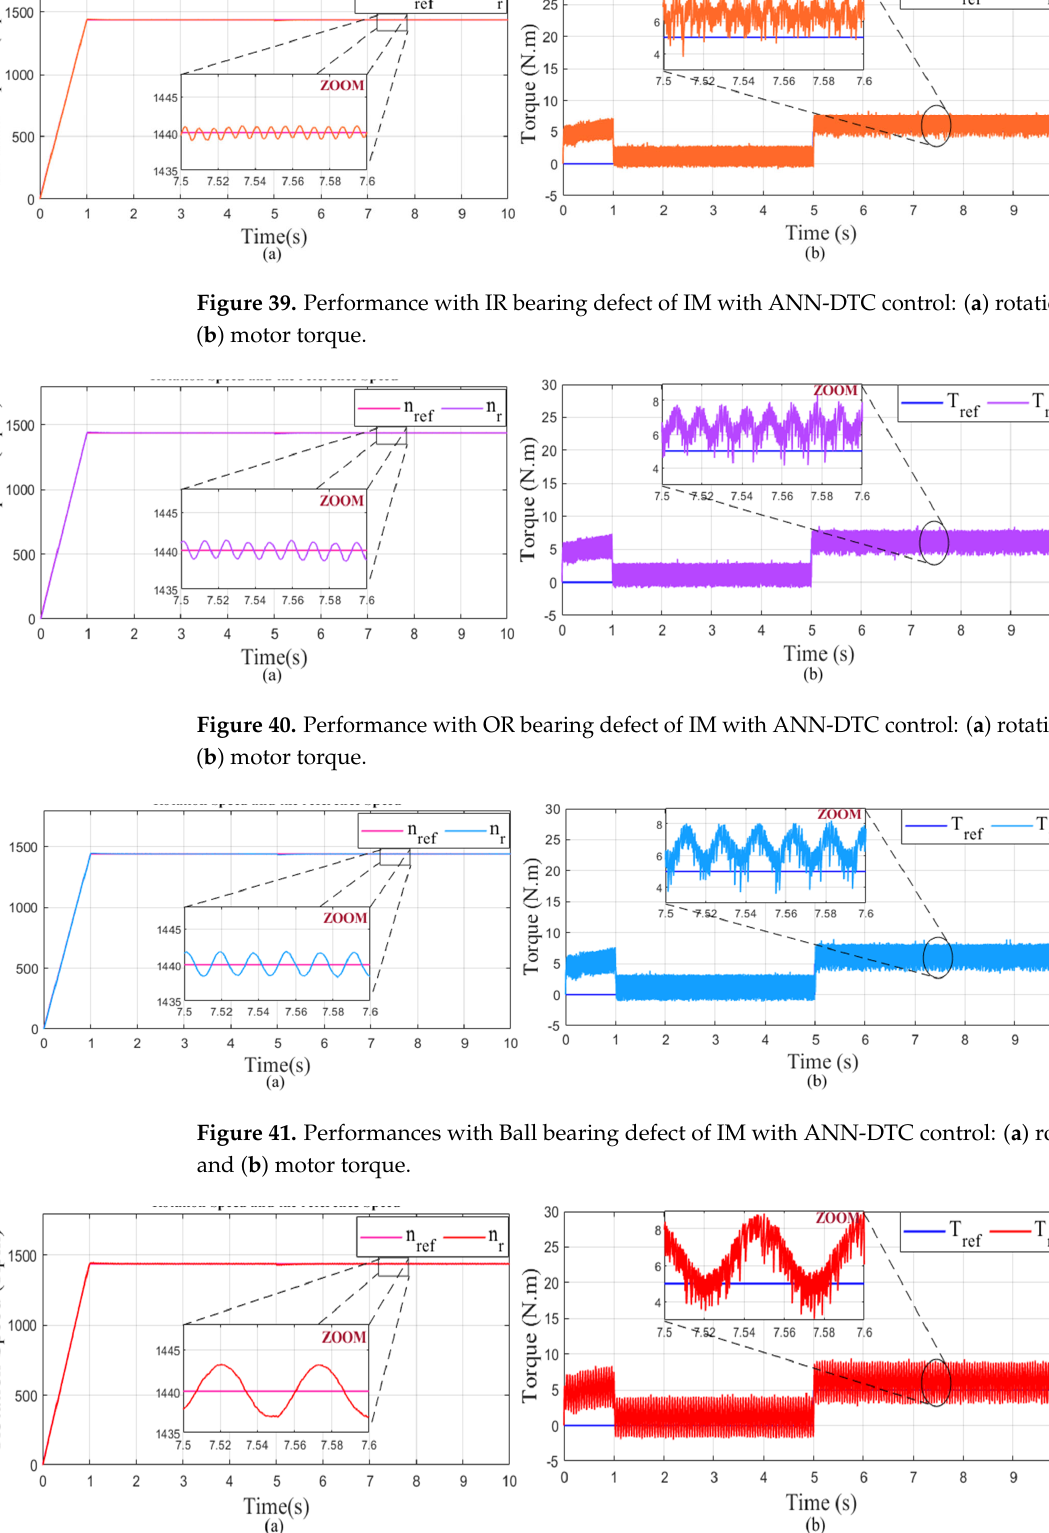
Figure 43. Performance in healthy state of IM with ANN ‐ DTC control: ( a ) Stator current and ( b ) THD at no ‐ load and ( c ) THD with load (5 Nm). Figure 44. Performance with IR bearing defect of IM with ANN ‐ DTC control: ( a ) Stator current and ( b ) THD at no ‐ load and ( c ) THD with load (5 Nm).